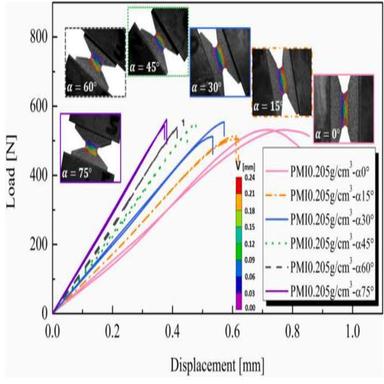
The load-displacement responses of pre-cracked PMI foam materials with density of 0.205 g/cm3 under combined tension-shear tests. When the loading angle α = 0◦, a pure mode II fracture is produced and the pre-crack would grow in a stable manner. When the loading angle α > 0◦, mixed-mode fractures are produced and the pre-crack would grow in an unstable manner.